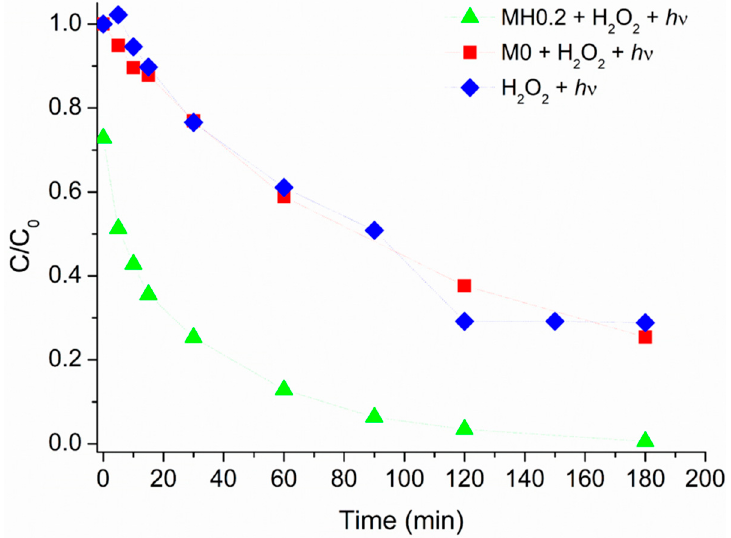
Figure 5. Caffeine relative photodegradation vs. irradiation time in the presence of: H 2 O 2 (1.50 × 10 − 3 M) (blue diamonds); bare magnetite (M0, 200 mg·L − 1 ) and H 2 O 2 (1.50 × 10 − 3 M) (red squares); MH0.2 (200 mg·L − 1 ) and H 2 O 2 (1.50 × 10 − 3 M) (green triangles). Data reported considering an initial caffeine concentration of 5 mg·L − 1 .